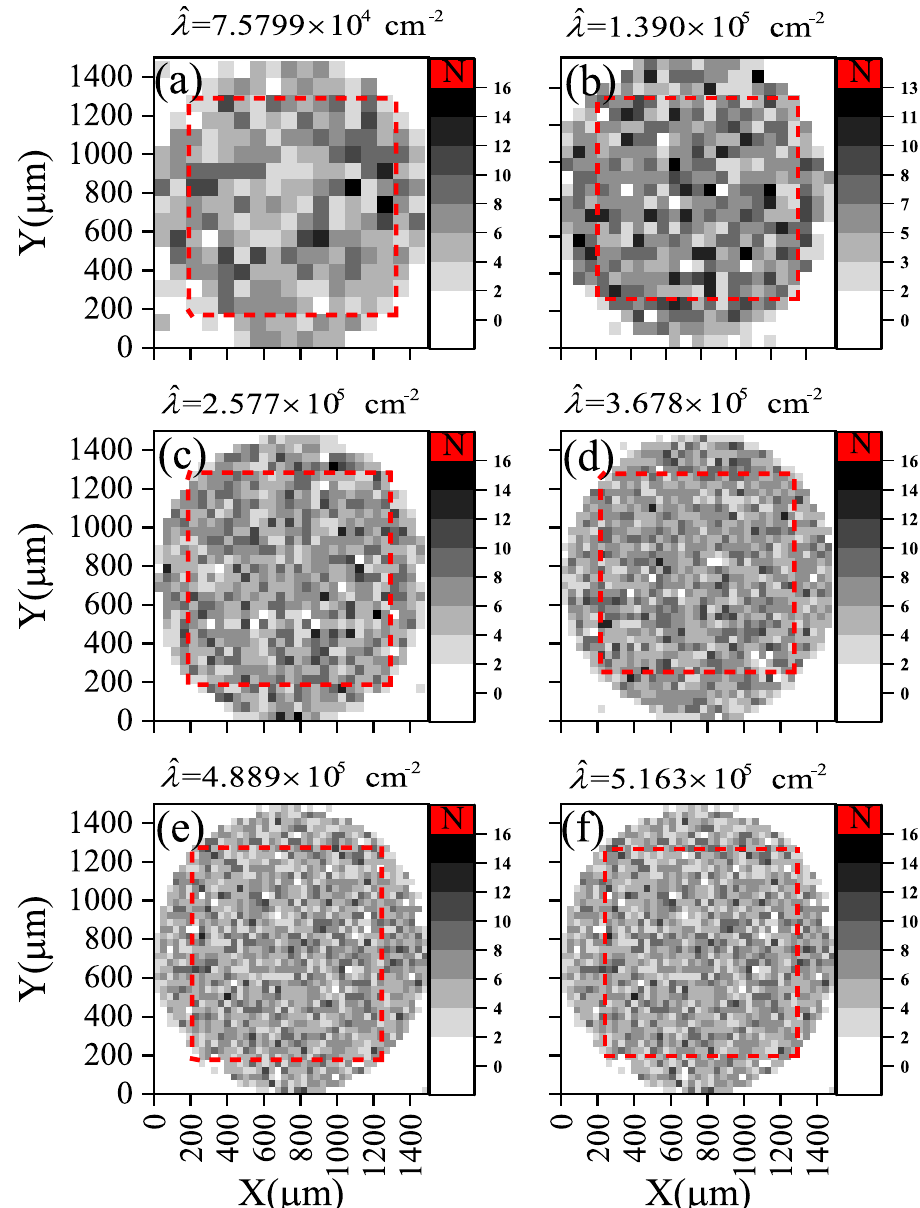
Figure 6. Heatmap for the investigated local track densities of samples a2, b2, c3, d2, e2, and f2 after being etched for 2 h. The grayscale represents the number of features in each quadrate, x i , while the number of quadrates increases progressively to fulfill Eq. (1). The dashed squares (red color online) show clipped areas containing quadrats used for Poisson distribution analysis; see